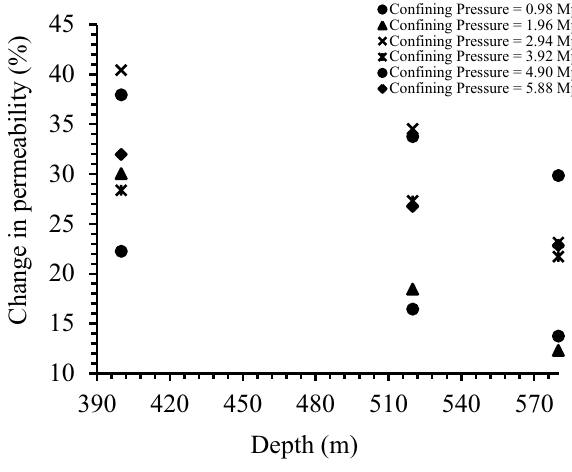
Fig. 11 Correlation of permeability with confining pressure